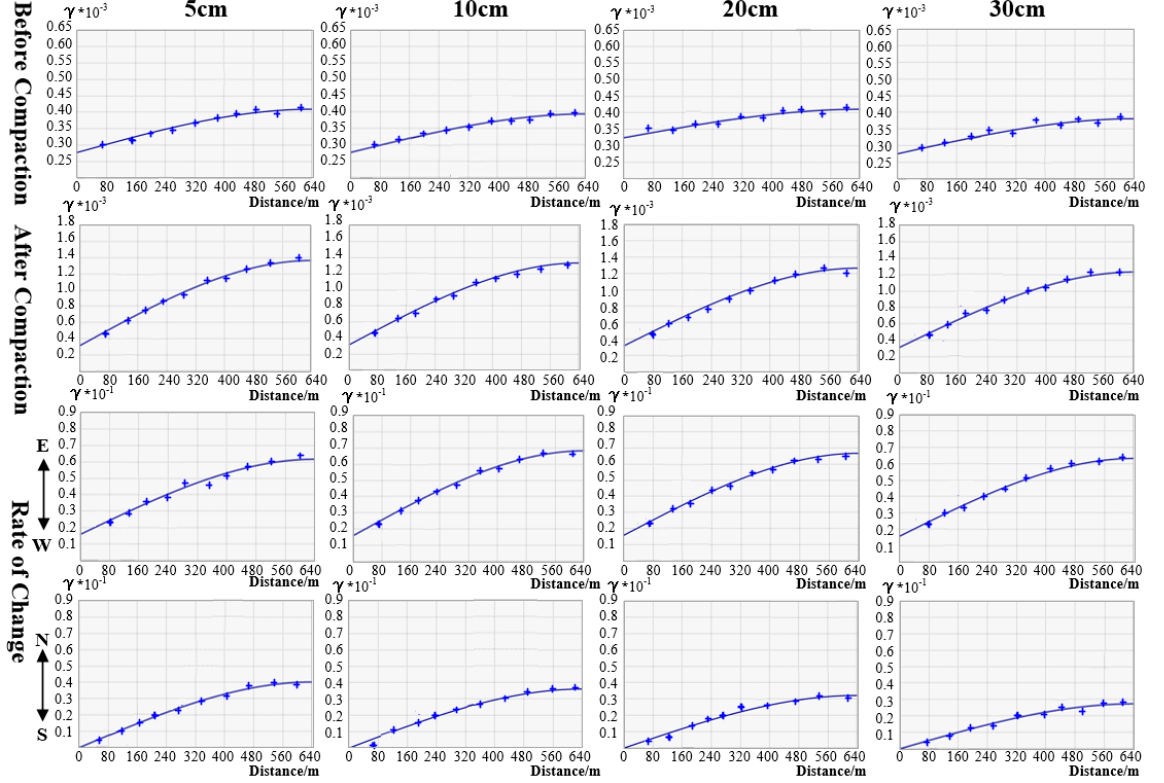
Figure 11. Transverse spatial semi − variance function of soil moisture content at various depths before and after compaction.